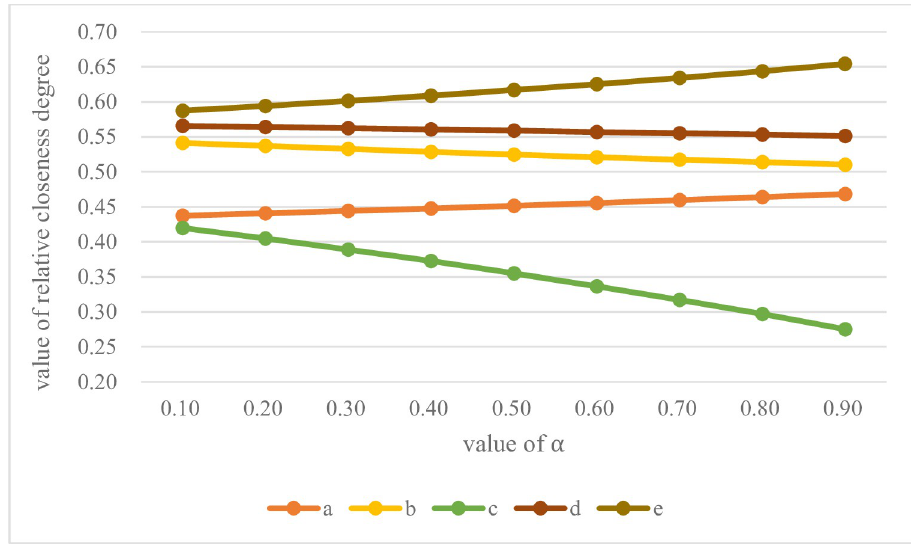
Fig 5. The TPGU ranking sequence